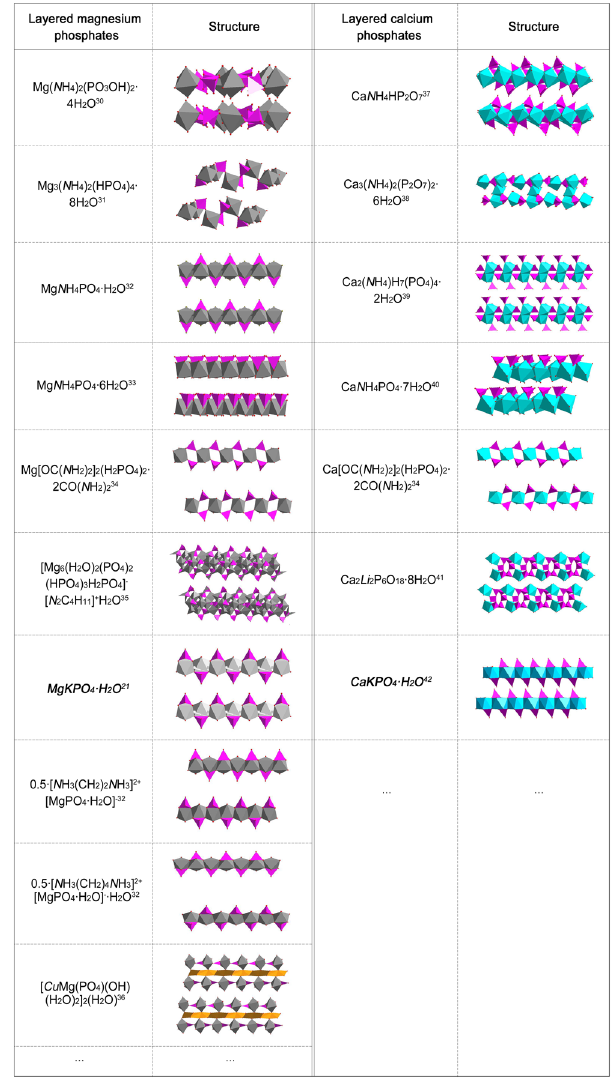
Figure 3. Families of layered magnesium and calcium phosphate compounds. (Interlayer cations are omitted) 30–42